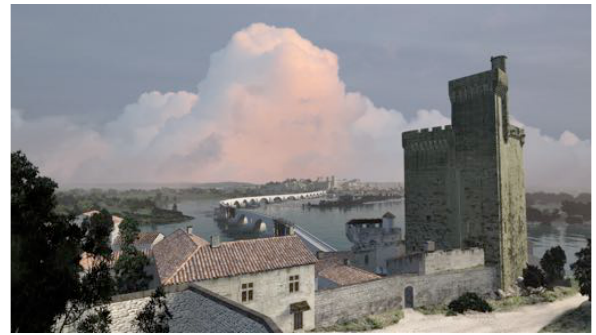
Figure 12. The final render of the Bridge, from Villeneuve side, in its hypothetical state in